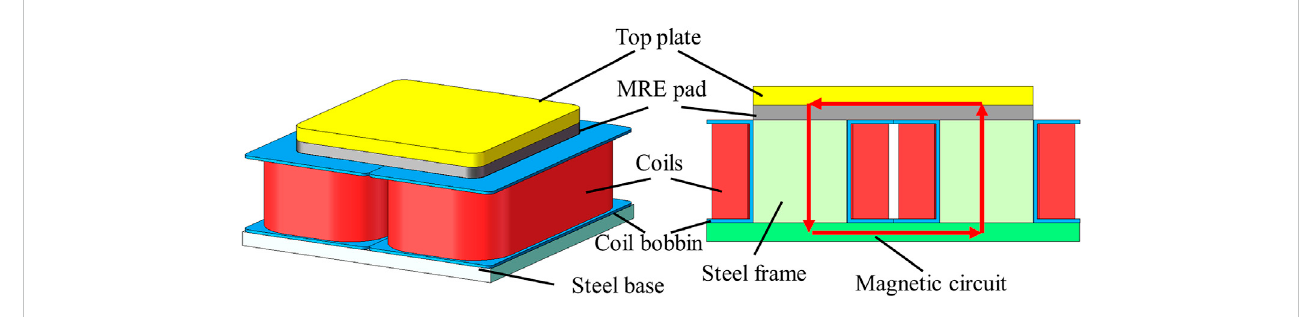
FIGURE 6 Design and structure of magnetic controlling unit coupled with MRE railway pad.